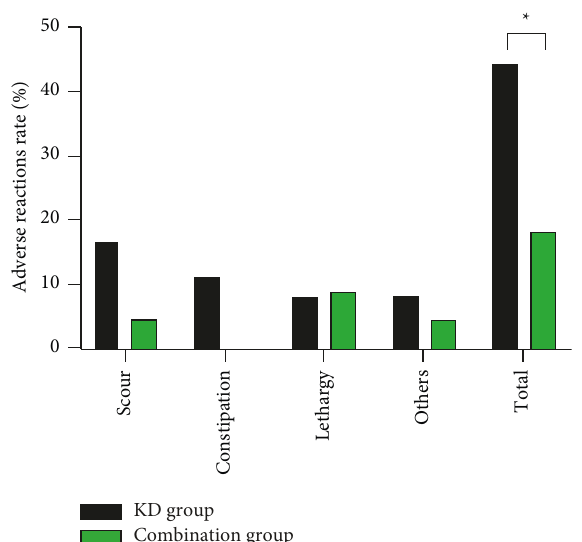
Figure 7: Adverse reactions between the two groups of children. ∗ was the difference between group comparisons, P < 0 .